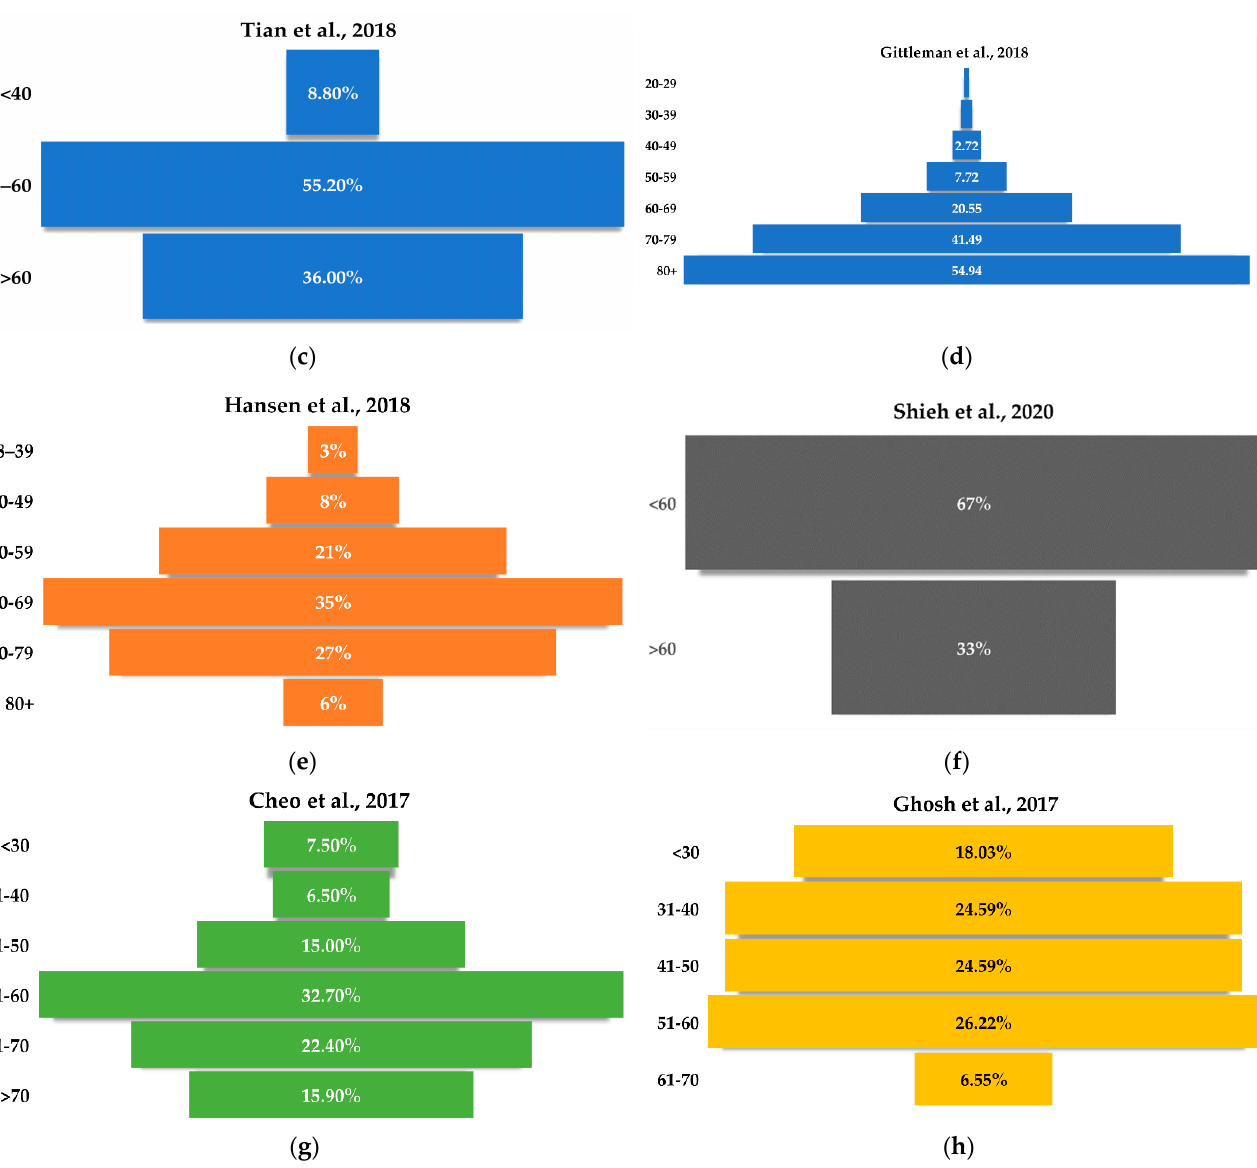
Figure 3. Age-related incidence of GBM (100,000/years) [14,100,101]. 4.3. Survival GBM is the most aggressive diffuse glioma of the astrocyte lineage and remains an incurable tumor. Table 2 presents survival data for GBM. In most cases, the median sur- vival was less than 15 months. In the study by Lam et al. [24], the median survival was 20, with 46.9% of subjects surviving for up to 2 years after diagnosis. In contrast, Fabbro- Peray et al. [6], Gittelman et al. [92], and Ostrom et al. [101] observed that patients most often lived for up to 1 year after diagnosis. Table 2. Survival time of GBM patients. Reference